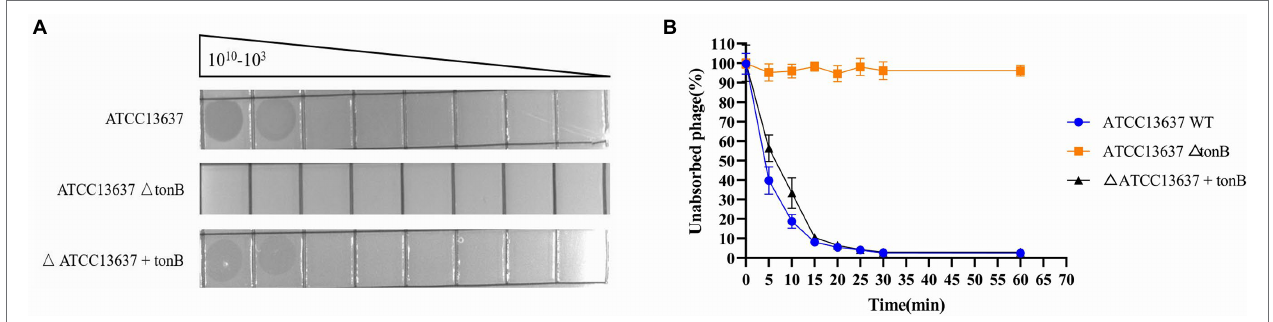
FIGURE 4 | Bacteriophage BUCT603 uses tonB protein as an adsorption receptor to infect Stenotrophomonas maltophilia ATCC13637. (A) Wildtype S. maltophilia ATCC13637 is susceptible to BUCT603 infection, whereas the Δ tonB mutant strain is resistant to phage infection, but complementation of ATCC13637 Δ tonB with the ATCC13637 tonB gene restores phage infection to wildtype levels. (B) BUCT603 can rapidly adsorb wildtype S. maltophilia ATCC13637, whereas BUCT603 cannot adsorb Δ tonB mutant strain, but BUCT603 restores adsorption to complementation of ATCC13637 Δ tonB with the ATCC13637 tonB